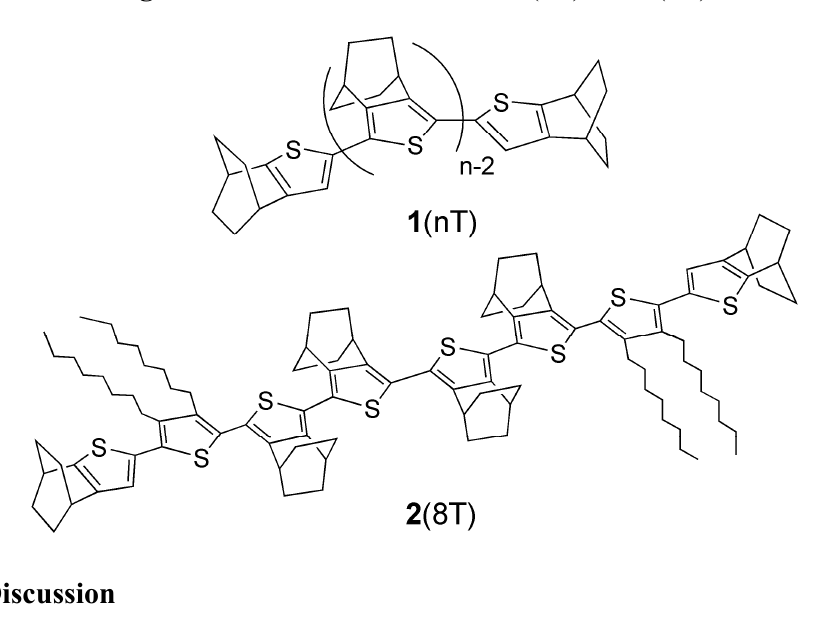
Figure 1. Chemical structures of 1 (nT) and 2